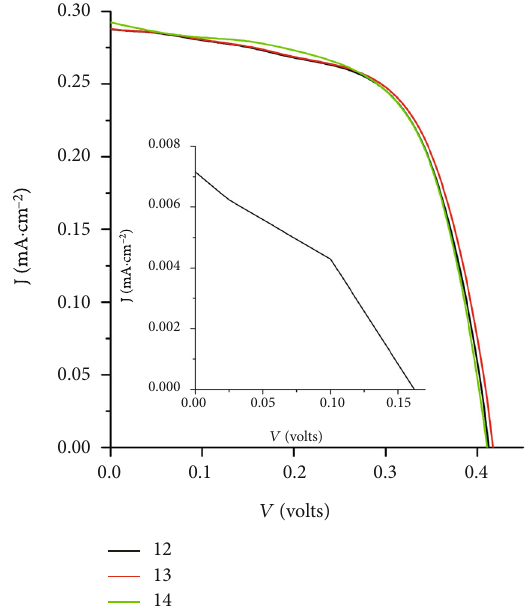
Figure 10: J vs. V curves from DSSCs sensitized with cyanines 12-14. The inset shows the J vs V curve from the device assembled with 13 without the coadsorption of